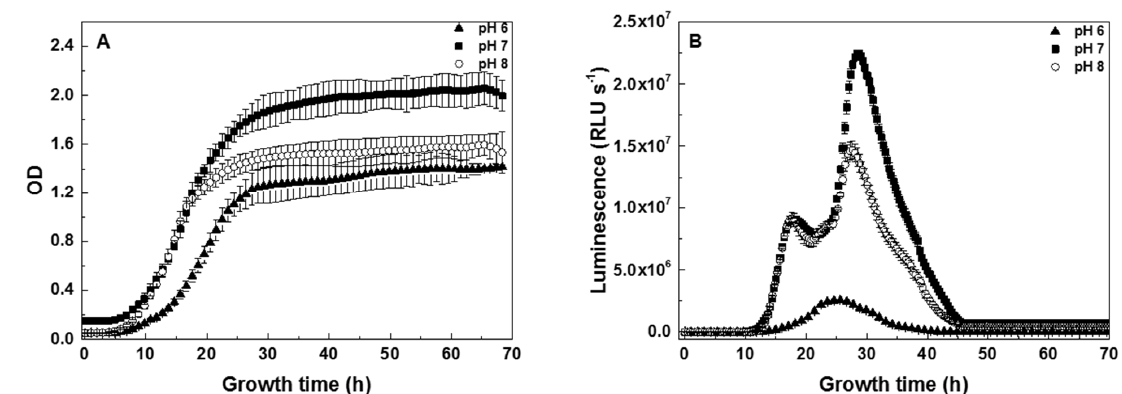
Figure 1. Continuous monitoring of V. fischeri aerobic growth at different pH. Data are shown with a different symbol for each of the three pH values and represent continuous measurements over 70 h of ( A ) optical density (OD) and ( B ) bioluminescence emission. Correlated initial (17 h) and secondary (28 h) peaks in bioluminescence are observed at pH 7 and 8, in contrast to a single peak (25 h) at pH 6.